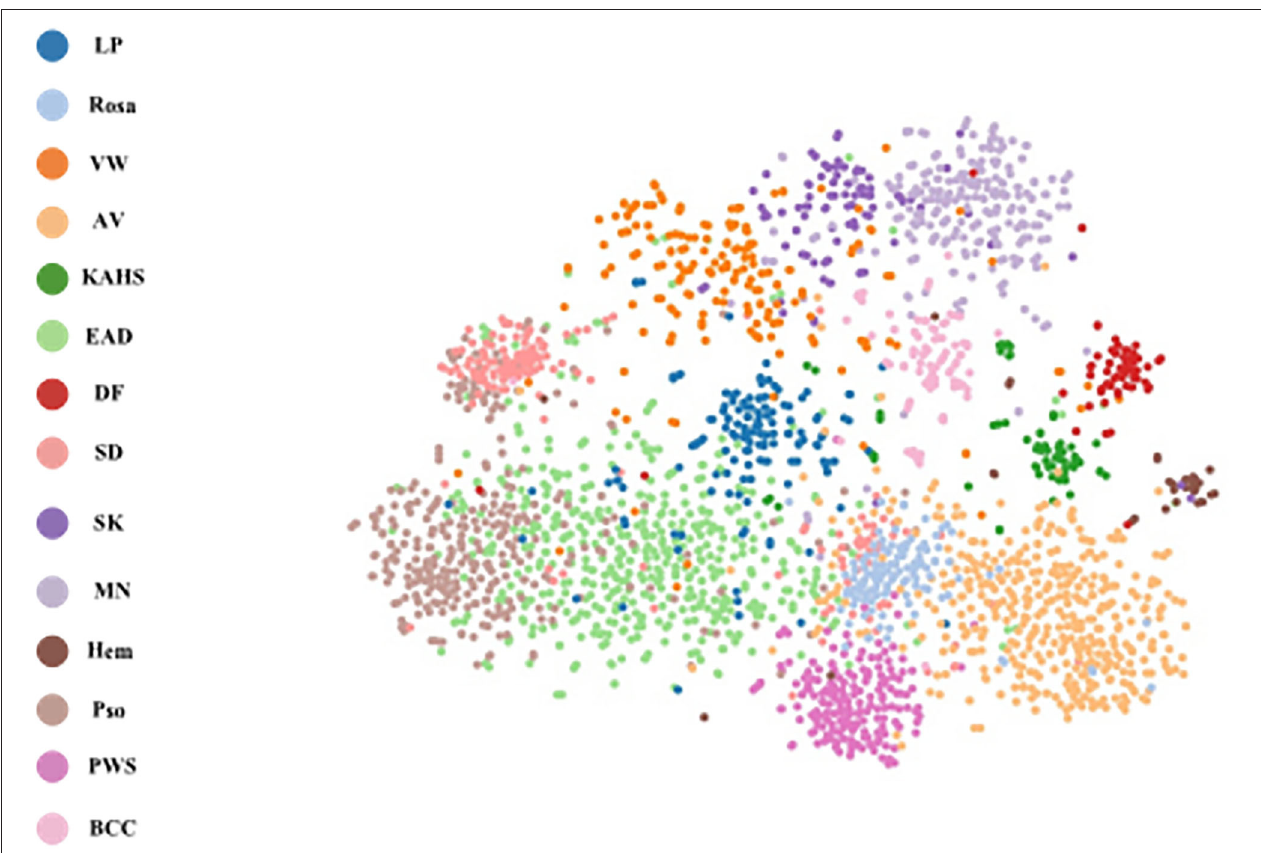
FIGURE 8 | t-SNE visualization of the last hidden layer representations in the CNN for four disease classes. Here we show the CNN’s internal representation of eight disease classes by applying t-SNE, a method for visualizing high-dimensional data, to the last hidden layer representation (1792-D vector) in the CNN. Colored point clouds represent the different disease categories, showing how the algorithm clusters the